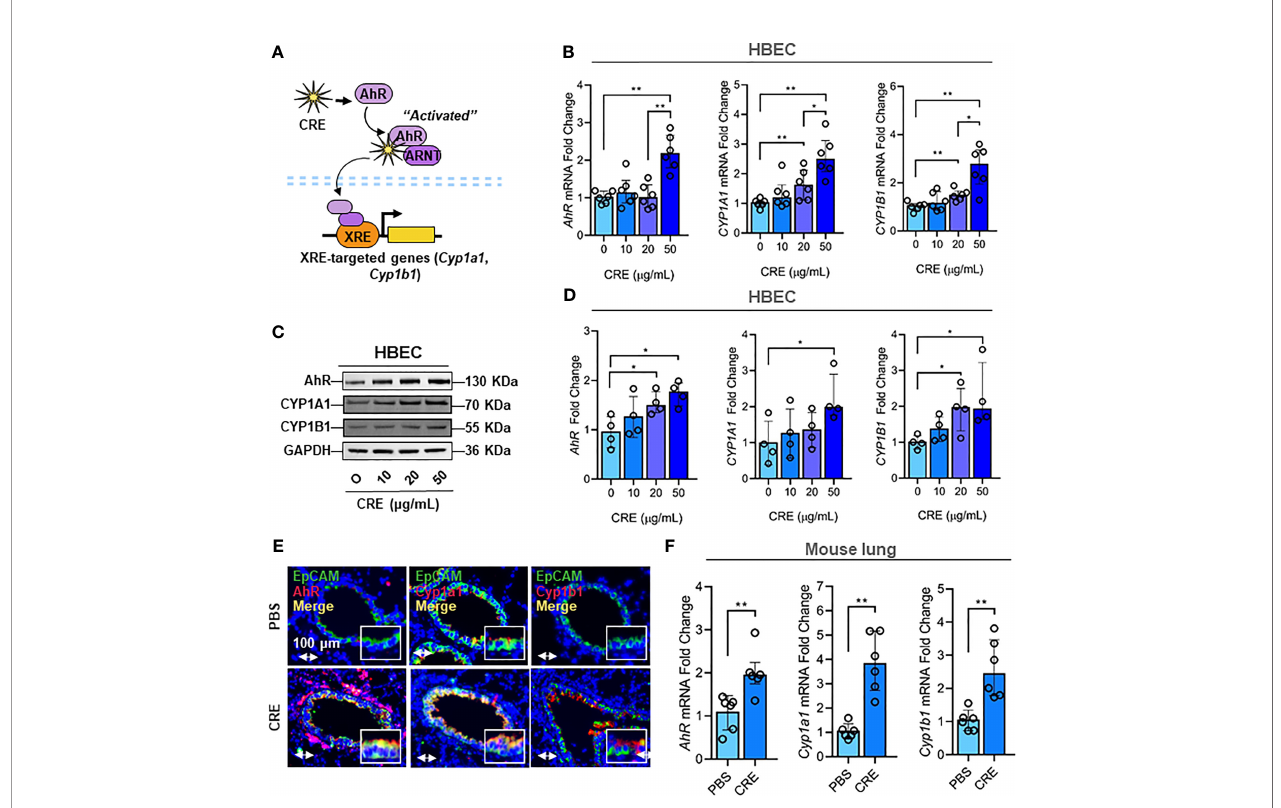
FIGURE 2 | Cockroach allergen exposure induces activation of AhR signaling pathway. (A) Scheme of cockroach allergen-induced the activation of AhR signaling. (B, C) expression of AhR, CYP1A1 and CYP1B1 in cockroach extract (CRE)-treated HBECs at different concentrations for 24 h (n = 6) as detected by RT-PCR [ (B) n = 6] and western blot (C) . GAPDH was detected as the loading control. (D) Quantitative analysis of western blots [ (C) , n = 4]. (E) Representative immuno fl uorescence images of AhR, Cyp1a1 and Cyp1b1 (red) in the airway epithelial cells (EpCAM, green) of cockroach allergen-induced mouse model. (F) Quantitative analysis of fl orescent signal [ (E) , n = 6]. Data represent as medians with interquartile (IQR). * P < 0.05, ** P <